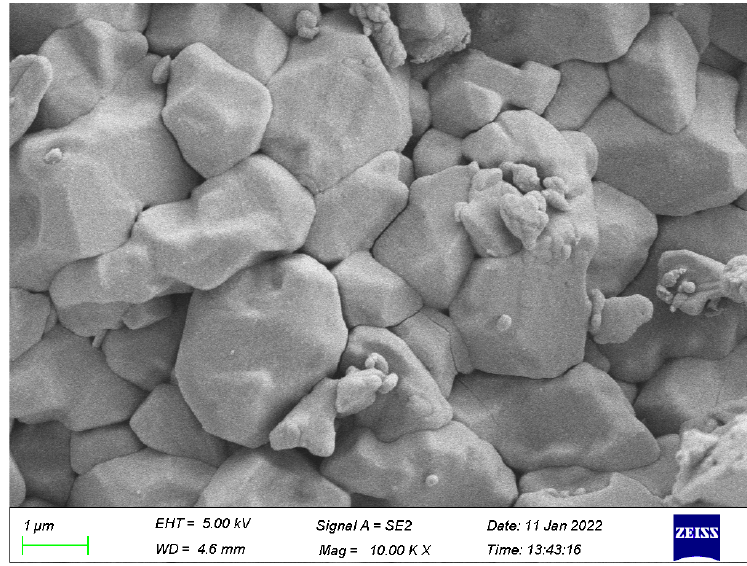
Figure 1. The microstructure of limestone.